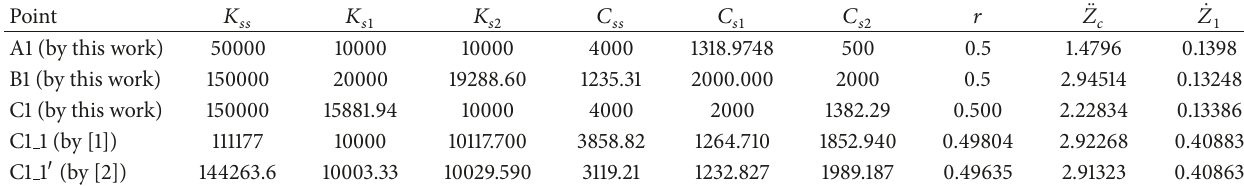
Table 5: Objective function values and trade-off design variables of [1, 2] and this work shown in Figure 15.